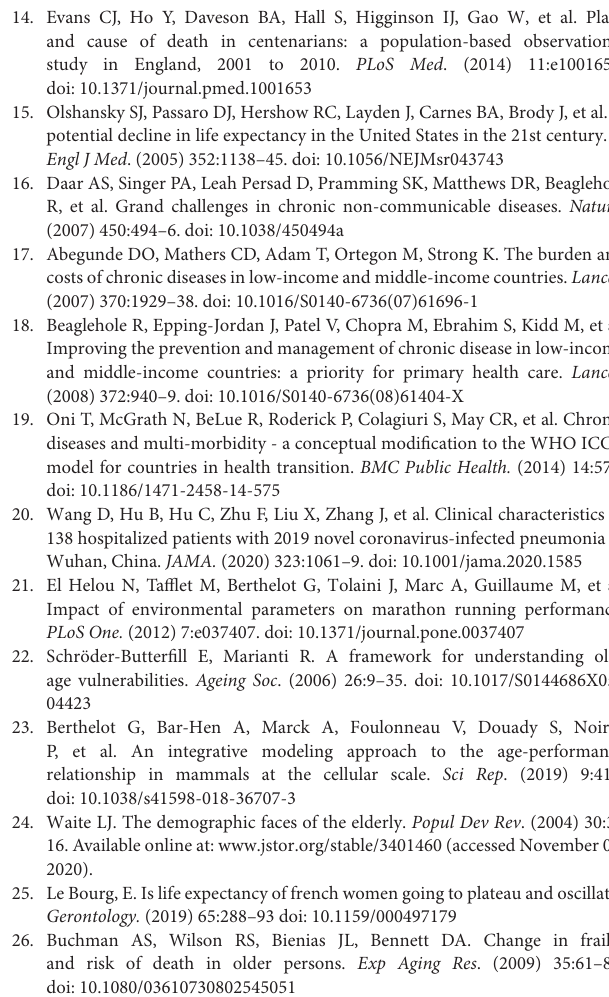
first epidemic wave. Supplementary Figure 1 | First factorial plan of the principal component analysis with the estimated data (see Section Methods—Data collection). Results are the same with estimated data and actual data. Supplementary Figure 2 | Coordinates of the variables of the principal component analysis with the estimated data (see Section Methods—Data collection). Results are the same with estimated data and actual data. Supplementary Figure 3 | Correlation matrix with the estimated death numbers obtained from the logistic equation (see Section Methods—Data collection). Results are the same with estimated data and actual data. Supplementary Figure 4 | Covid-19 mortality is expressed in numbers in the top figures and in rates in the bottom figures. It is expressed in raw data on the left and in decimal logarithm on the right. Supplementary Figure 5 | The position of the countries on the graph represents their correlation according to the variables of the first factorial plane. For example, countries positively correlated to axis 1 (right), will be positively correlated to variables to the right of axis